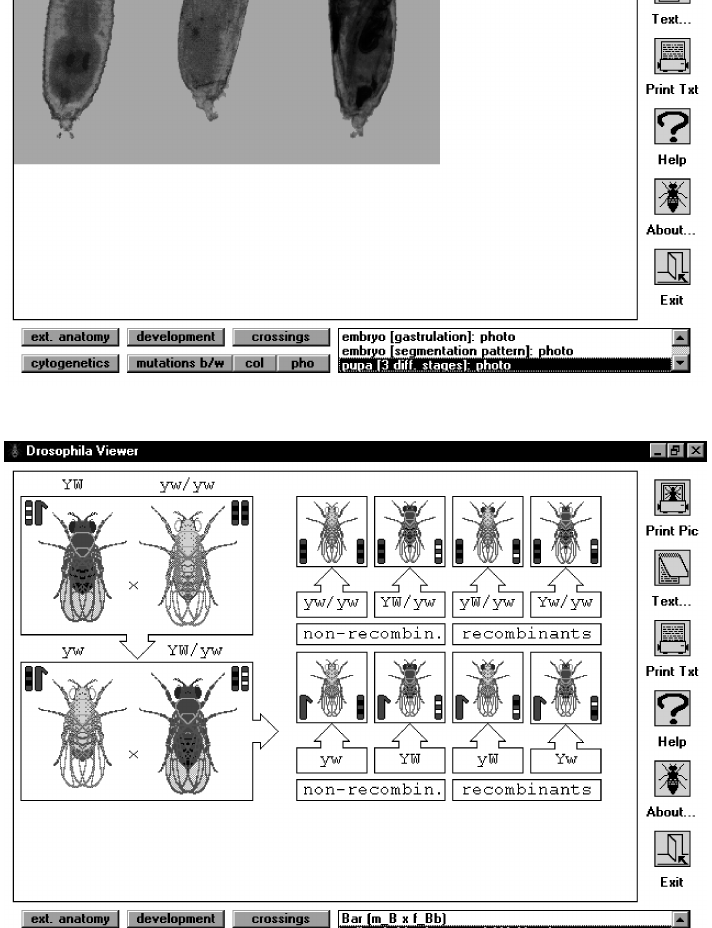
Figure 6 - Diagram illustrating non-independent assortment of two X-linked mutant recessive characters, yellow and white. Original drawing, based on Morgan et al. ( The Mechanism of Mendelian Heredity , Holt, N. York, 1923). The picture was se- lected by clicking the item in the option list shown on the right after pressing the command button